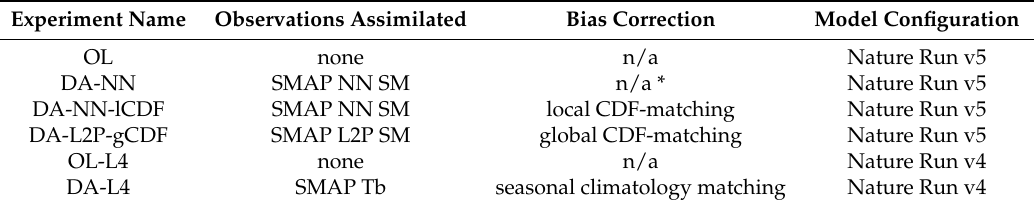
Table 3. Overview of the soil moisture (SM) model and data assimilation experiments. CDF: cumulative distribution function; NN: neural network; OL: open loop; DA-NN: SMAP NN retrieval assimilation without bias correction; DA-NN-lCDF: SMAP NN retrieval assimilation with local CDF-matching; DA-L2P-gCDF: SMAP Level-2 passive retrieval assimilation with global CDF-matching; DA-L4: SMAP Level-4 brightness temperature assimilation product; Tb: raw brightness